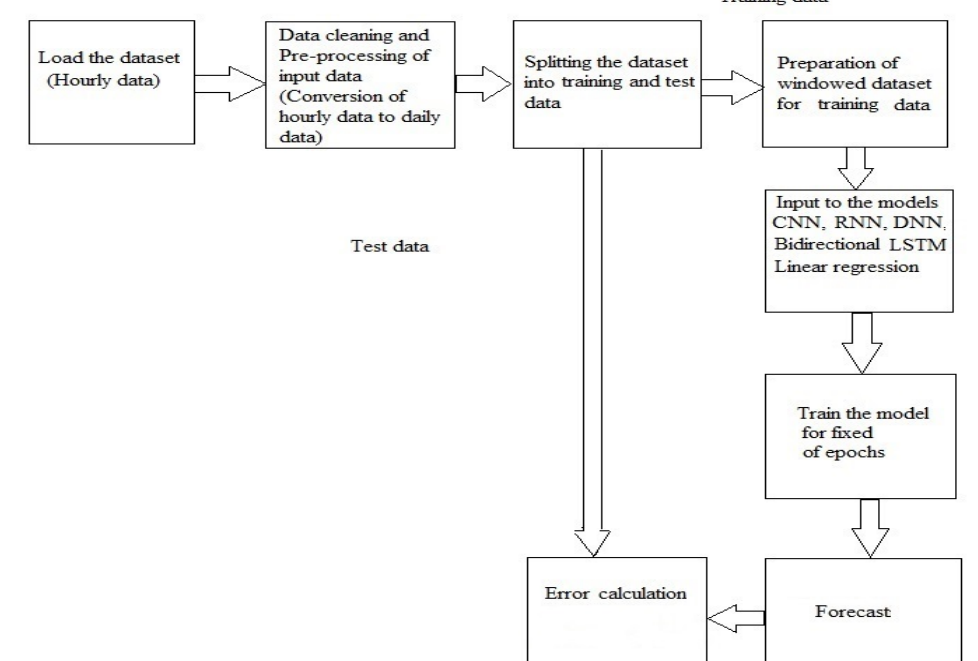
Figure 2. Schema t ic representation of the proposed methodology for the prediction of wind power